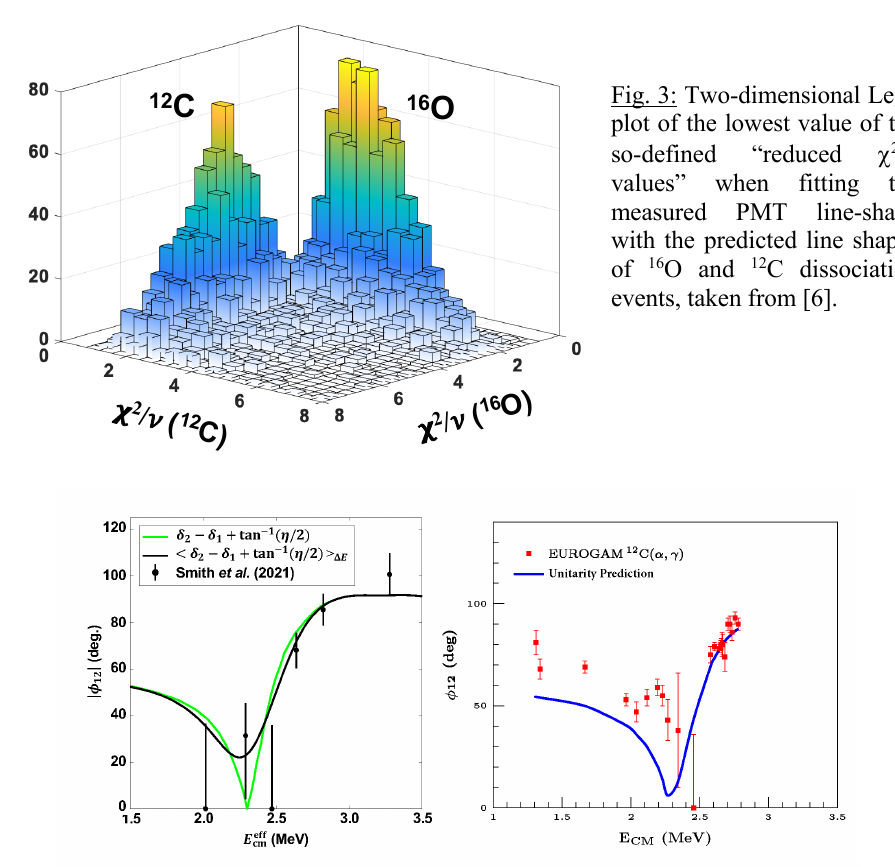
Fig. 4: The E1-E2 mixing phase angle ( f 12 ) measured by the EUROGAM collaboration [4], and our low statistics O-TPC results [6]. New higher statistics data were measured in August 2022, with the Warsaw eTPC [7]. Analysis of the new data is in progress.